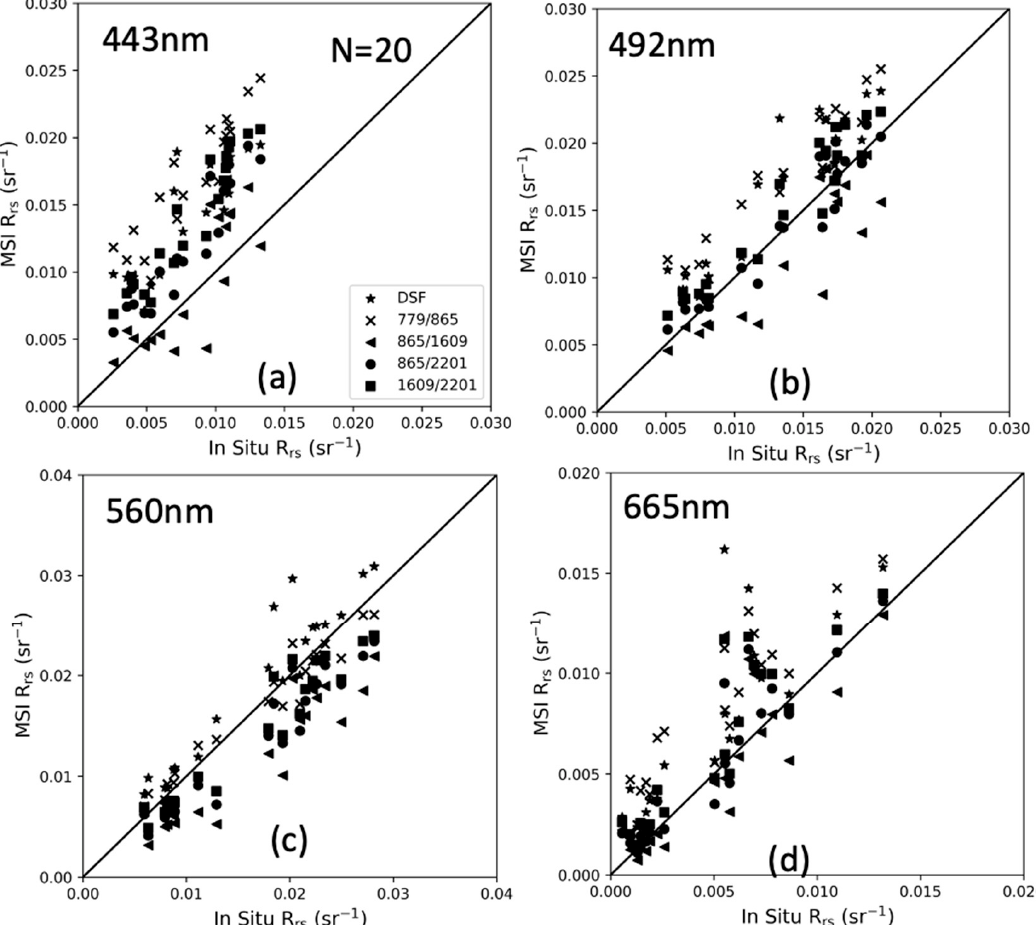
Figure 14. Validation of MSI-derived remote sensing reflectance ( R rs ) with in situ measurements at the Dong’ou and Muping sites at ( a ) 443 nm, ( b ) 492 nm, ( c ) 560 nm, and ( d ) 665 nm. The MSI Level 1C data were processed to R rs using the ACOLITE with the dark spectrum fitting (DSF) and exponent extrapolation (EXP) models with four band combinations (779/865, 865/1609, 865/2201, and 1609/2201).